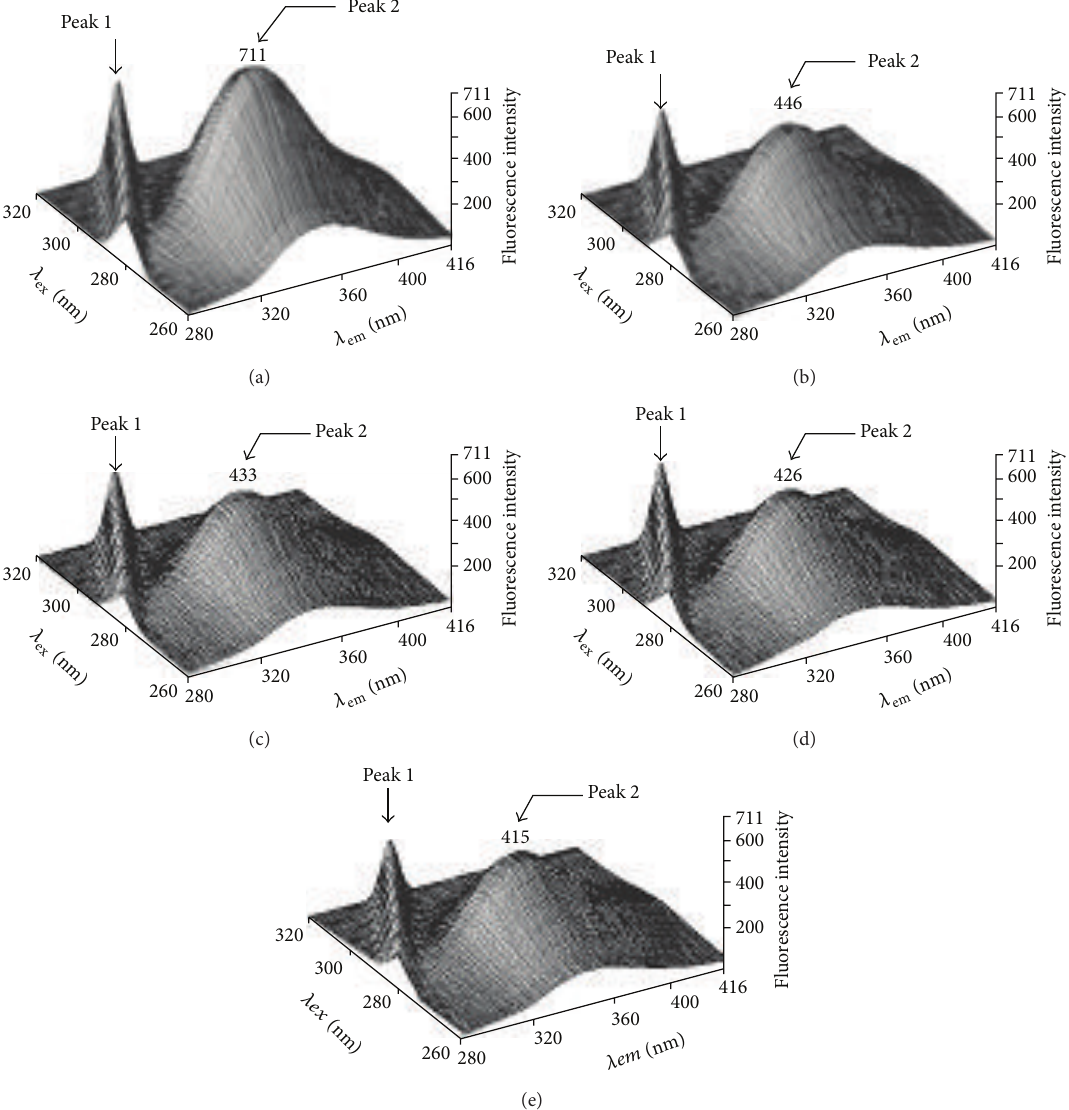
Figure 10: Three-dimensional fluorescence spectra of HSA (a), Hyp-HSA without glucose (b), Hyp-HSA with 3mM glucose (c), Hyp-HSA with 6 mM glucose (d), and Hyp-HSA with 9mM glucose (e) at 310 K; 𝐶 (